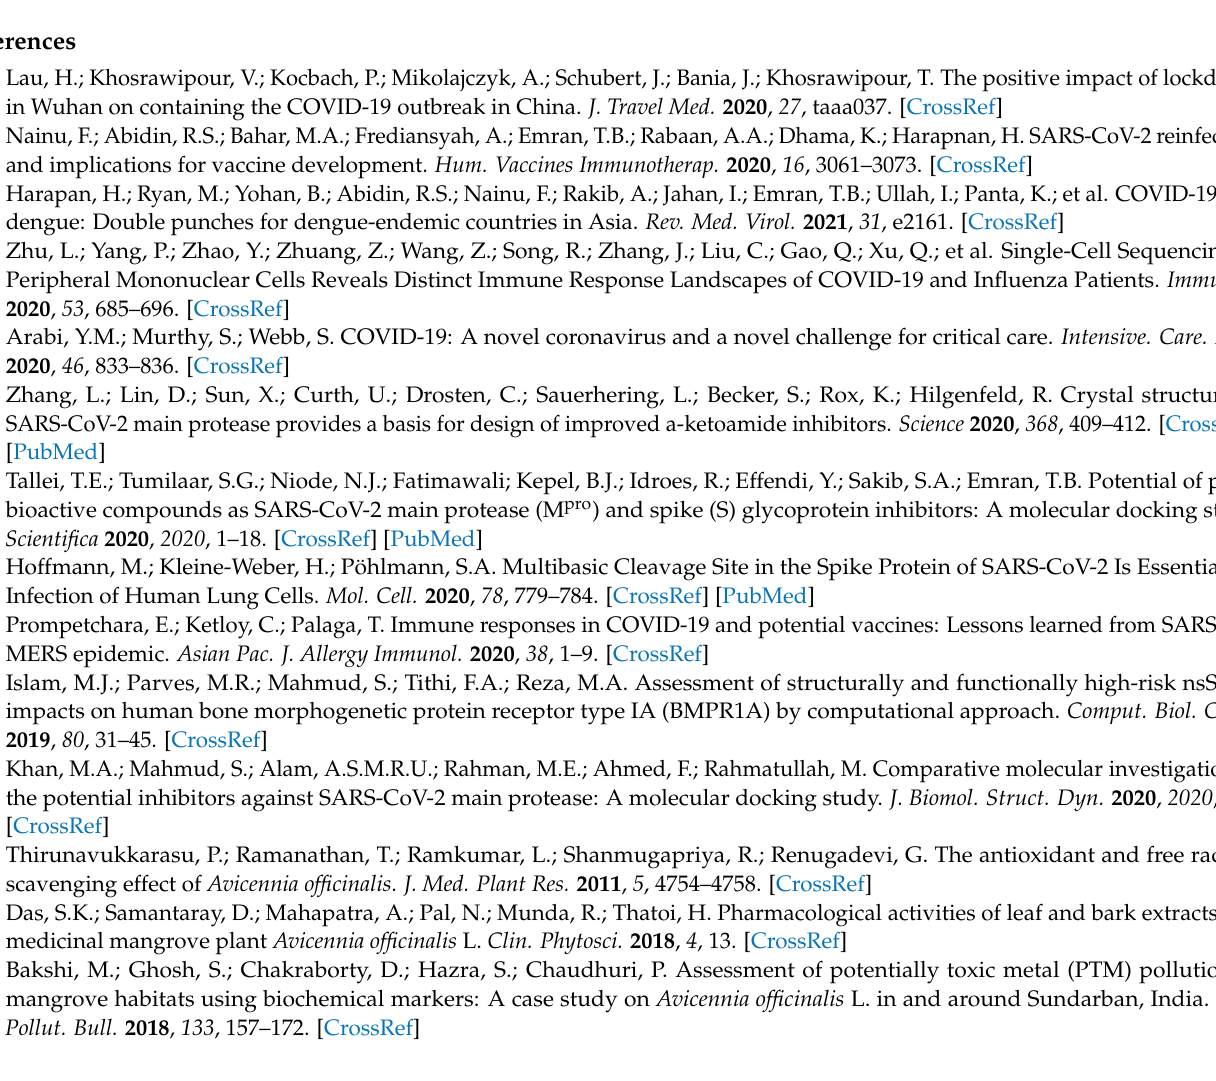
Table S4: Phytochemical compounds identification from Avicennia officinalis plant fruits extract by GC-MS. Table S5: Pharmacological assessment of all the